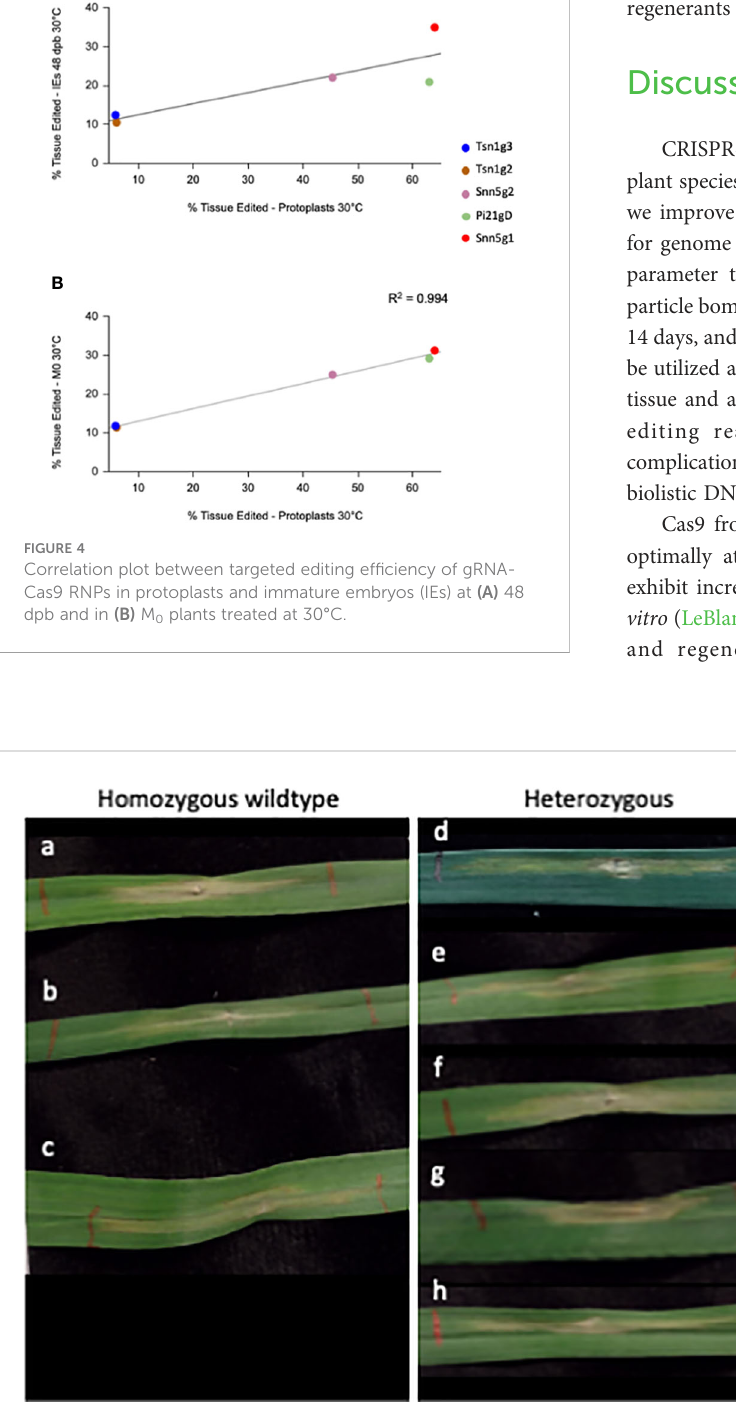
FIGURE 5 SnToxA assay in Tsn1 targeted M 0 regenerants. (A) Fielder control grown from seed. (B – M) Independent M 0 regenerants with (B, C) homozygous wildtype; (D – H) heterozygous (D) -2; (E) -5; (F) -31; (G) -1; (H) +1; and (I – M) biallelic or homozygous mutant (I) -2, -5; (J) -2, -2, (K) -1, -1; (L) -2, -2; (M) -1, -1 genotypes. Mutation notation is as follows: a positive number, +, indicates the number of bases inserted, a negative number, -, indicates the number of bases